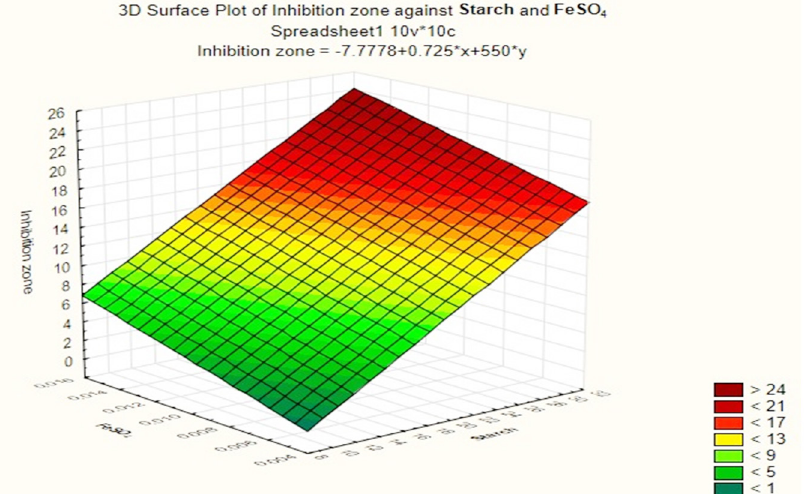
.7H Owith respect to inhibition zone diameter of 4 2